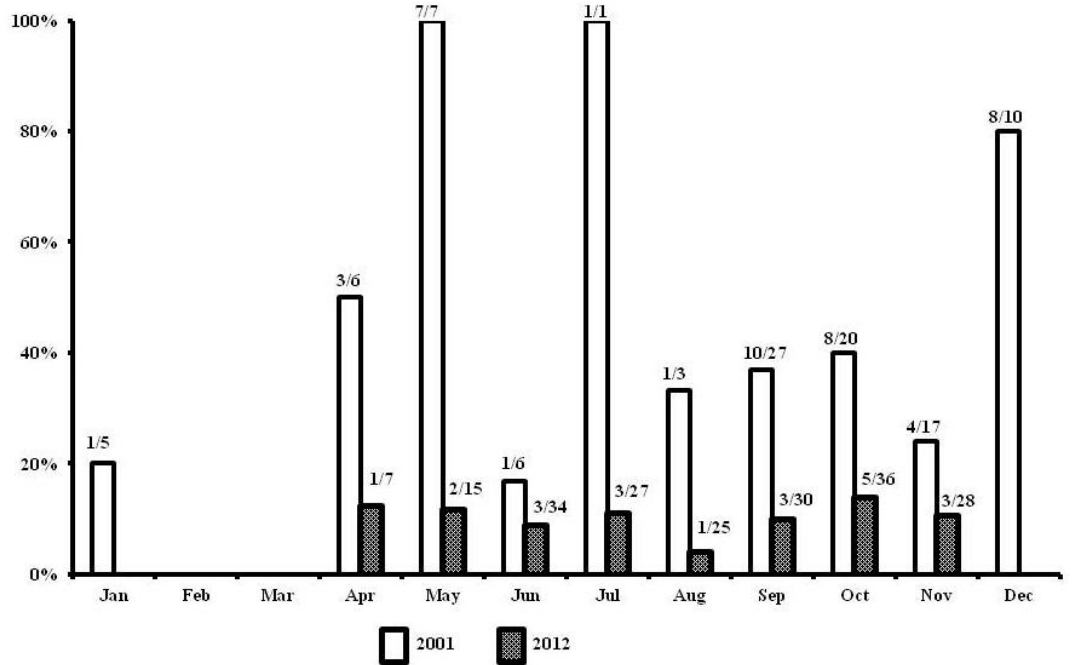
Figure 1. The proportion of leptospirosis amongst patients with acute undifferentiated fever in 2002 and 2012. (The figure above each bar represents the number of leptospirosis cases diagnosed among total number of AUFI).